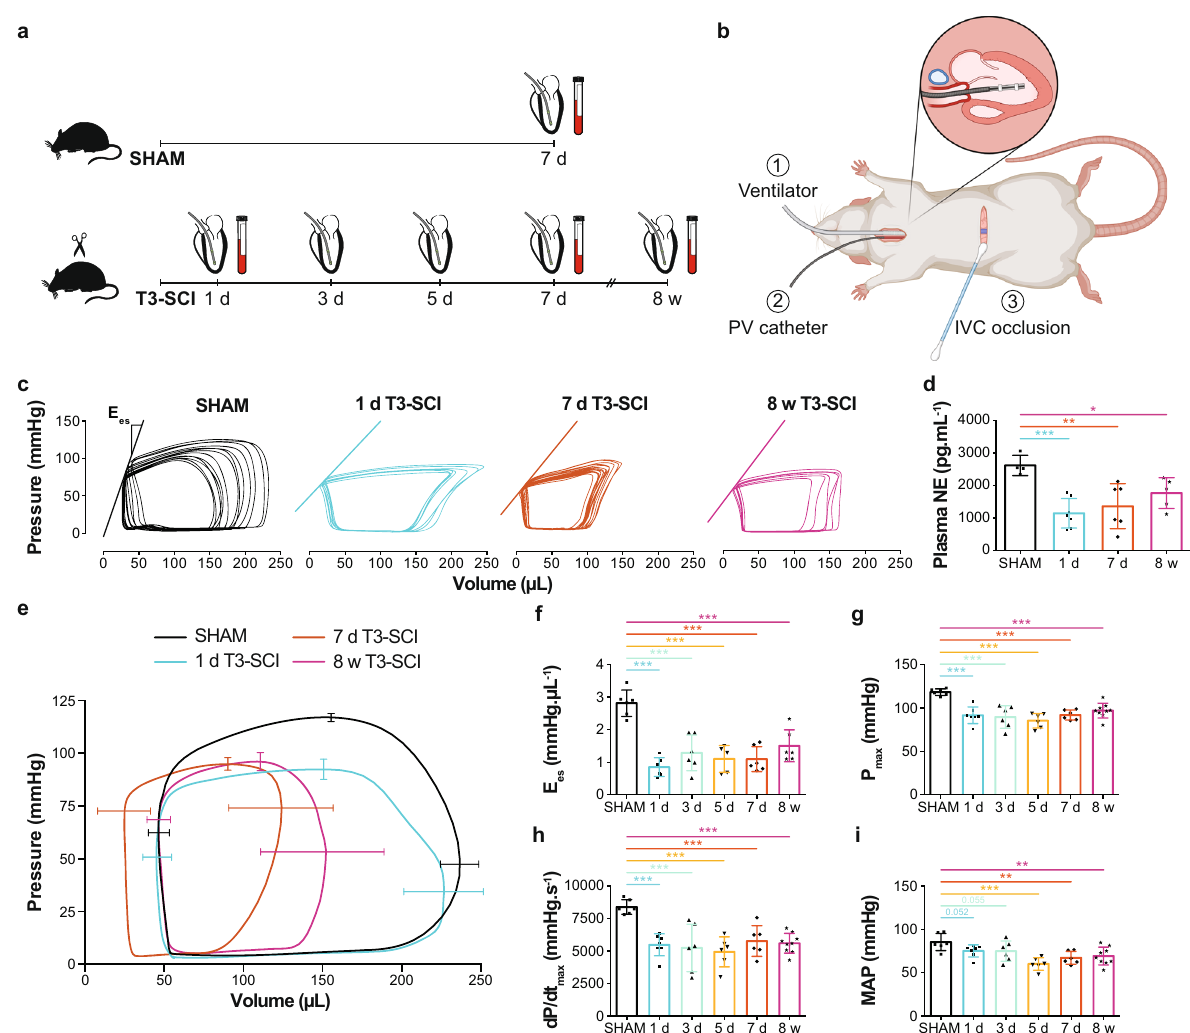
Fig. 4 Temporal progression of changes in catheter-derived hemodynamics, LV function, and plasma norepinephrine (NE) in rats with SHAM injury